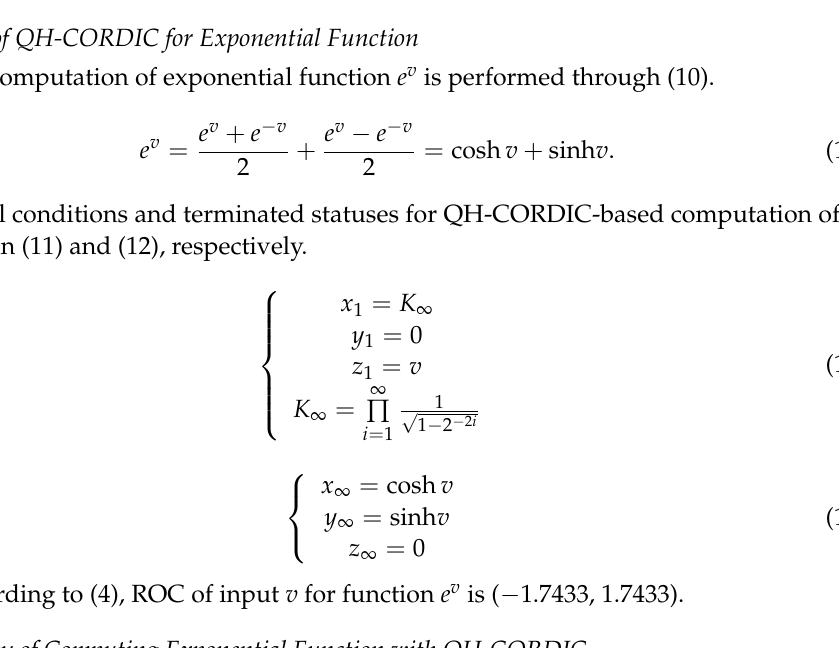
Figure 2. ( a ) QH-CORDIC in vectoring mode; ( b ) QH-CORDIC in rotating